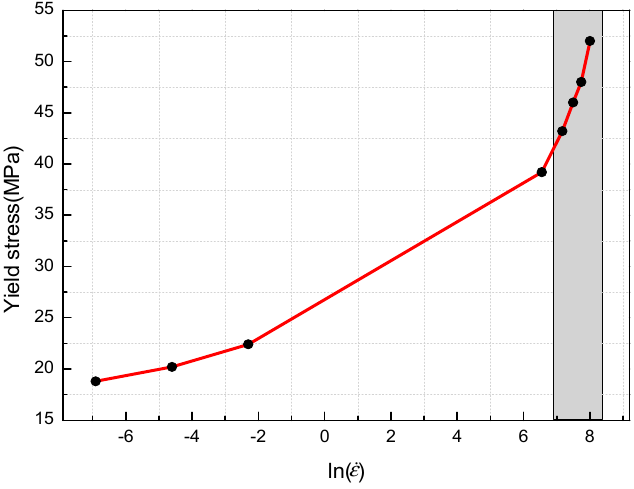
Figure 9. Relationship between yield stresses and logarithm train rates.